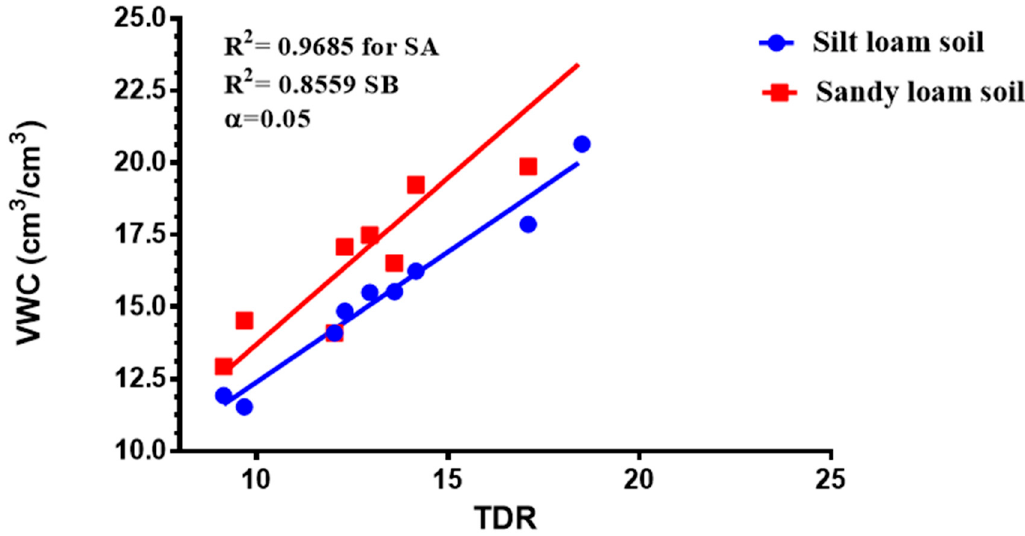
Figure 2. Difference in the moisture content determination by the volumetric water content (VWC) and TDR ( ± 5%) for sandy loam soil (SA) and (SB) silt loam soil.